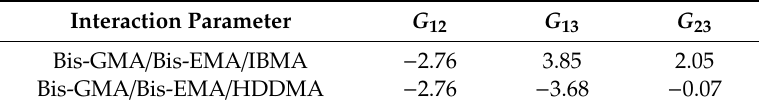
Table 2. Interaction parameters determined for monomer